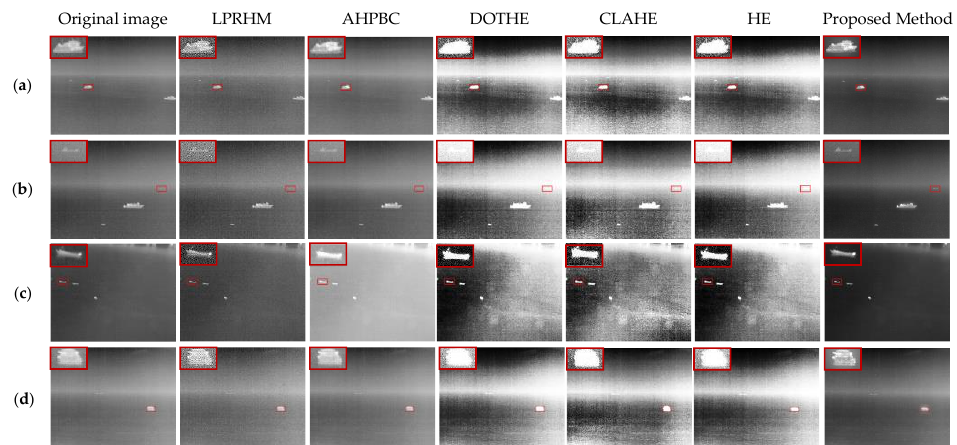
Figure 15. Comparison of the enhancement effect of the calm sea surface. ( a – d ) are the experi-